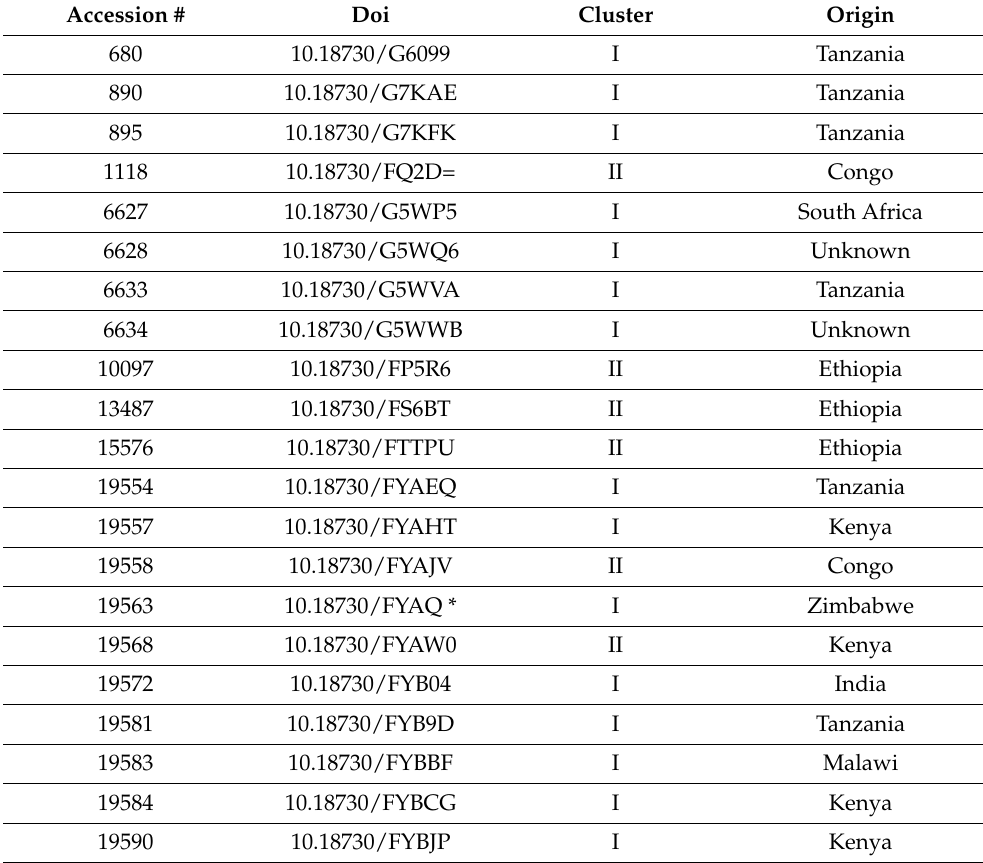
Table 4. List of accessions, origin, and cluster groups contained in subset developed using SNP